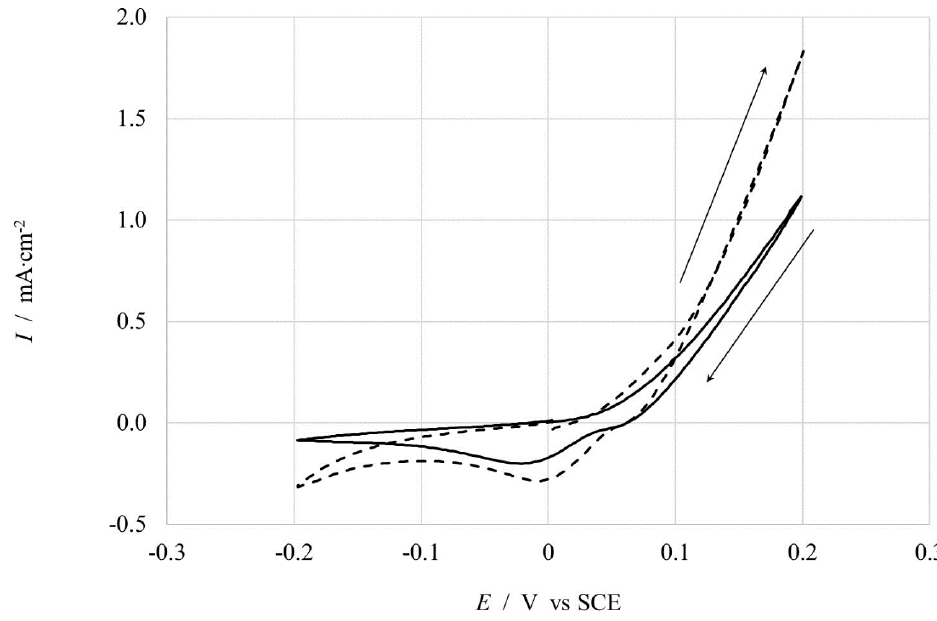
Figure 8. CV in 0.5 M KNO 3 at 20 mV s − 1 ; new pipe ( continuous ), Cu aged 8 weeks ( dotted